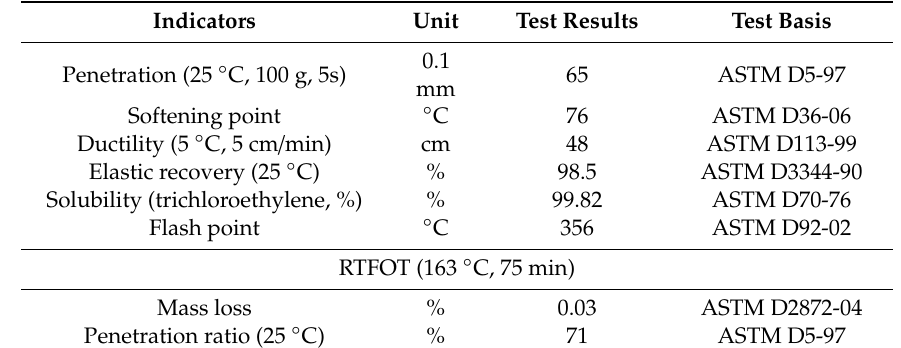
Table 1. SBS-modified asphalt test results and technical indicators.